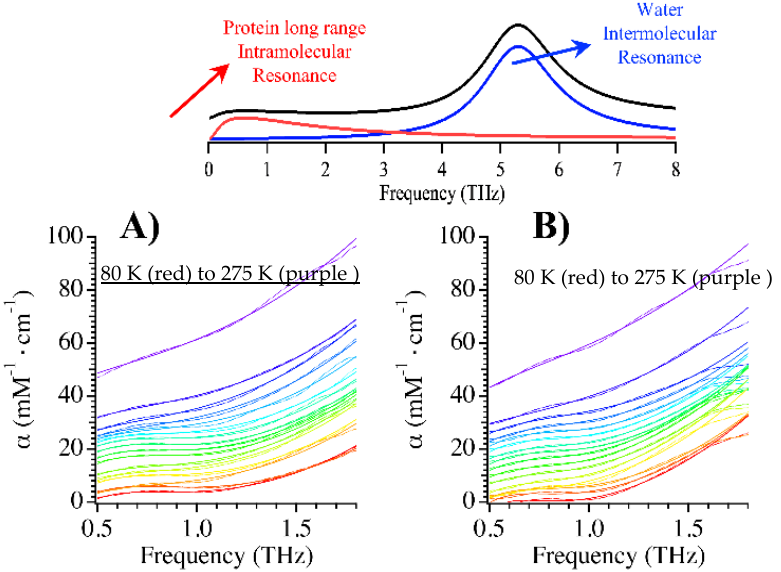
broadening is consistent with additional excitations accessible with increasing thermally activated mobile waters. Figure 6B shows the frequency, amplitude, and linewidth of the low frequency band for the unbleached protein. The central frequency is nominally at 0.6 THz and blue shifts at higher temperatures, in agreement with the QHA peak in Figure 4. Both the amplitude and linewidth increase at a transition temperature of 210 K for the unbleached TagRFP-T. That is, the dynamical onset temperature for the low frequency protein motions is higher than that of the solvent. We will define two onset temperatures, from the sharp turn-on points of each curve, T DS for the solvent and T DP for the protein. Figure 6D shows the results for the photobleached TagRFP-T. The photobleached state T DP shifts up to 230 K, while the solvent T DS remains the same. mCherry has the same result (see Figure S4 in Supplementary Information). The picosecond water dynamics turn-on at 200 K for both unbleached and bleached protein, whereas the unbleached T DP is 210 K and bleached is 230 K. Just as the melting temperature shifts up with bleaching, so does the turn-on for the picosecond dynamics. For mOrange2, the solvent transition is again at 200 K for both unbleached and bleached proteins. For unbleached mOrange2, the protein dynamical turn- on is again at 210 K, but the bleached mOrange2 is substantially different, with the protein dynamical transition nearly absent and a slight inflection at 220 K. In all three cases, the protein temperature dependence is not identical to the solvent.